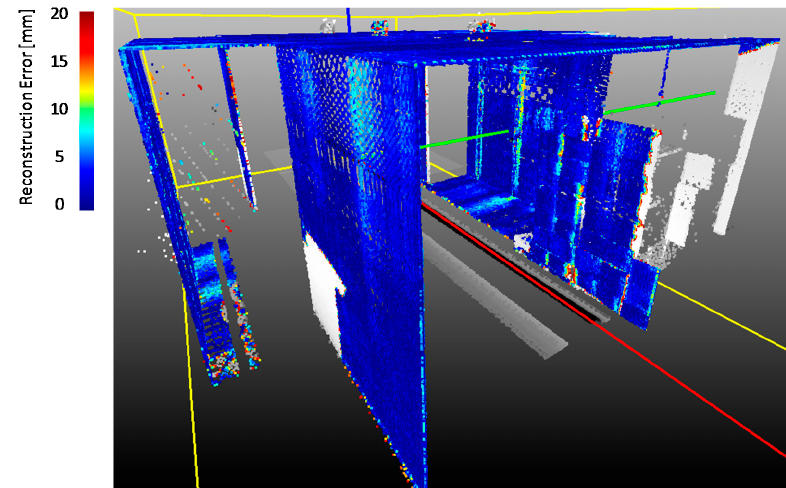
Figure 7. Reconstruction of the corridor.